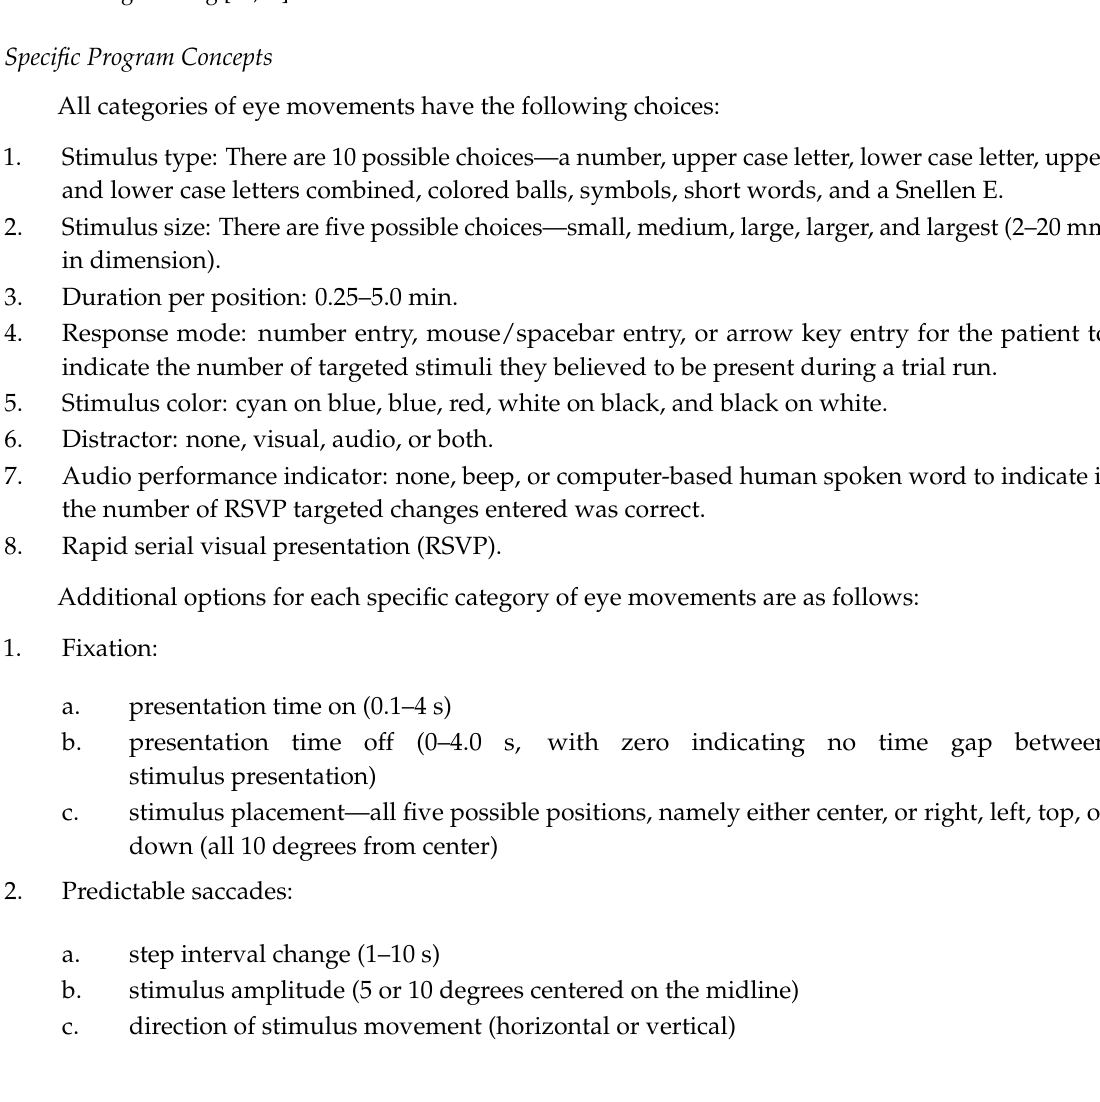
Figure 1. ( a ) CORe program home page ( b ) Sample interface screen of CORe program for simulated reading training [17,26].